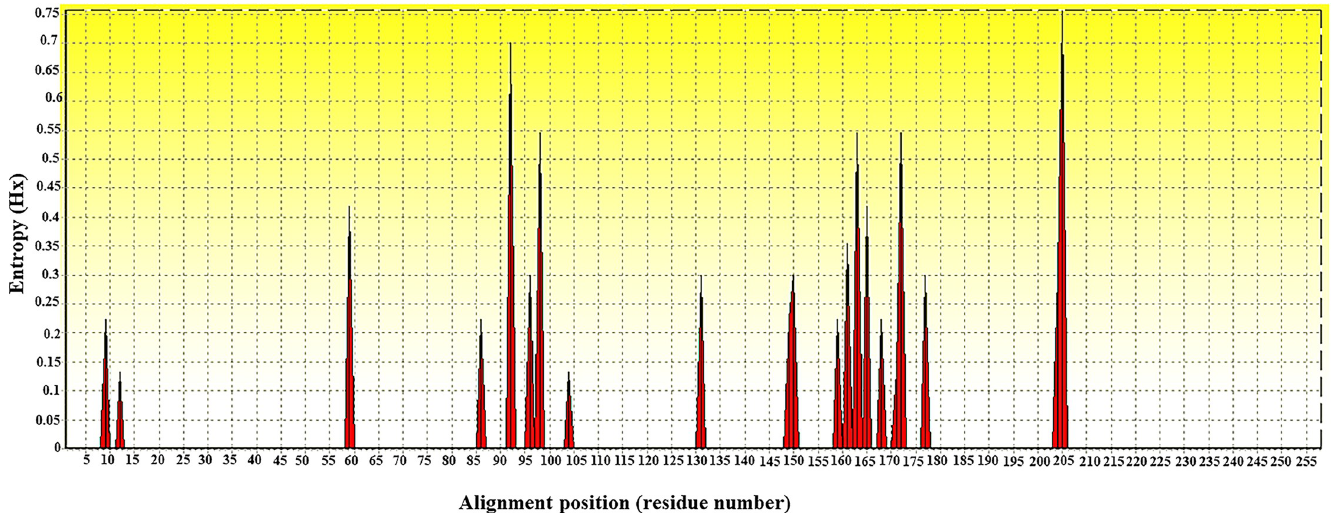
Fig 7. Entropy plot of partial DnaK amino acid sequences of Coxiella sp. Entropy plot of multiple amino acid sequence alignment of dnaK -encoding genes. The red peaks indicate high variation at each position of the amino acid sequences including at positions 9, 12, 59, 86, 92, 96, 98, 104, 131, 149, 150, 159, 161, 163, 165, 168, 171, 172, 177, 204 and